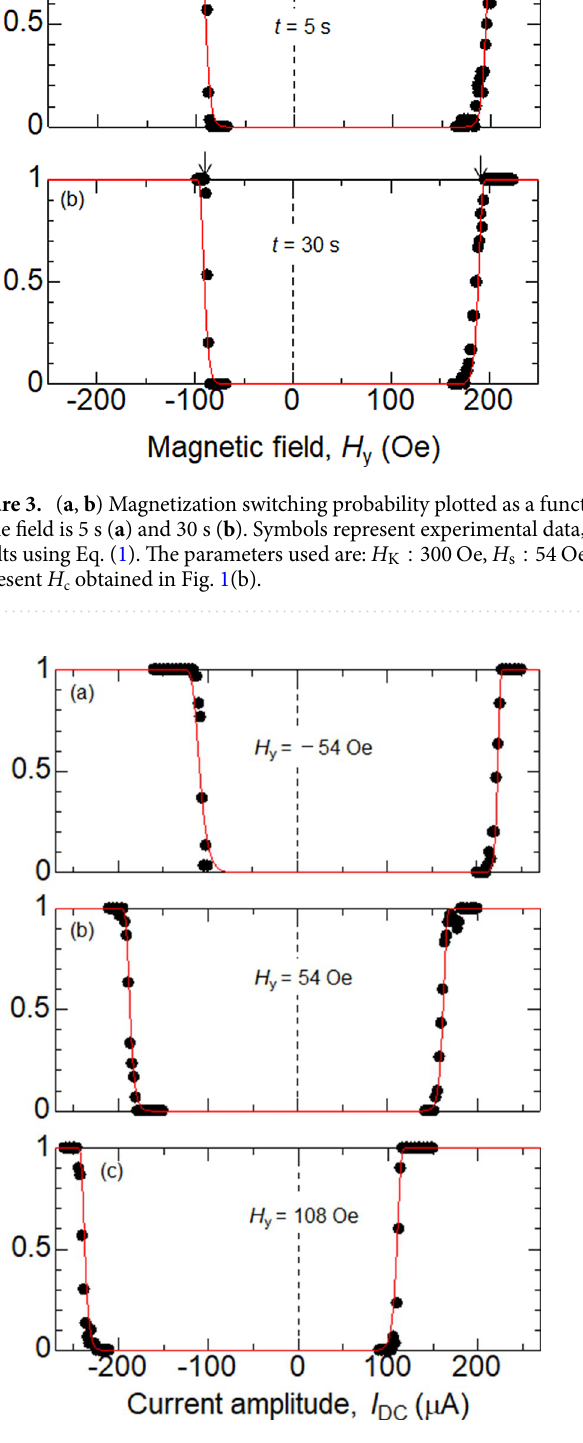
Figure 4. ( a – c ) Magnetization switching probability plotted as a function of the DC current I DC . The bias field H y is varied as indicated. Switching probability is obtained using 1 s long DC current. Symbols represent experimental data, the red solid lines show the fitting results using Eq. (1). The parameters used for the fitting are listed in Table